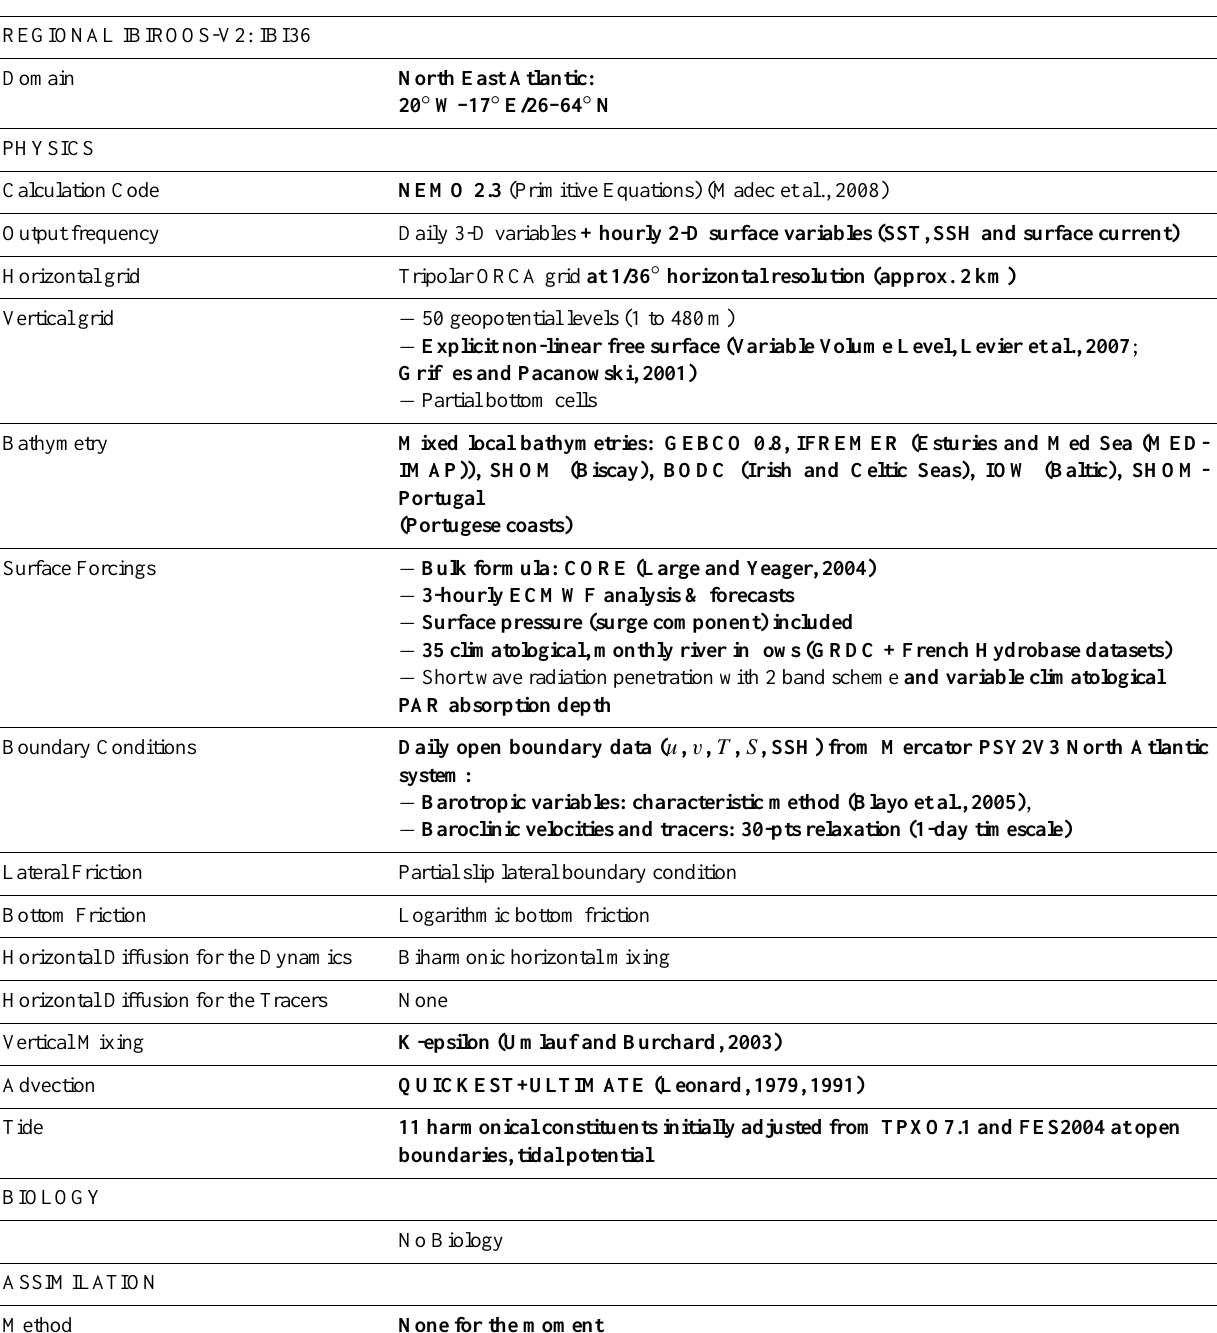
Table 3. Description of regional IBIROOS-V2: IBI36. Differences between V2 and V1 versions are written in bold characters. REGIONAL IBIROOS-V2: